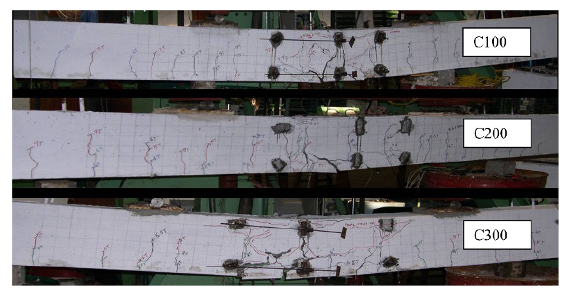
Figure 8. Formation of cracks in coated beams.